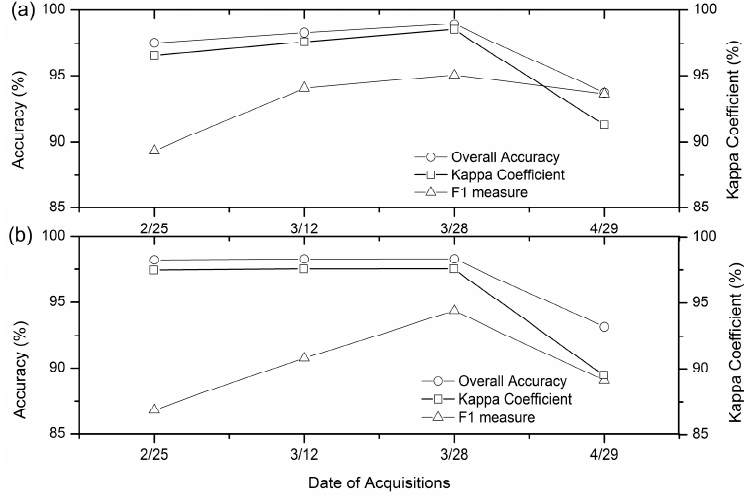
Figure 6. Accuracy of winter wheat using each optical image alone for RF ( a ) and SVM ( b ).